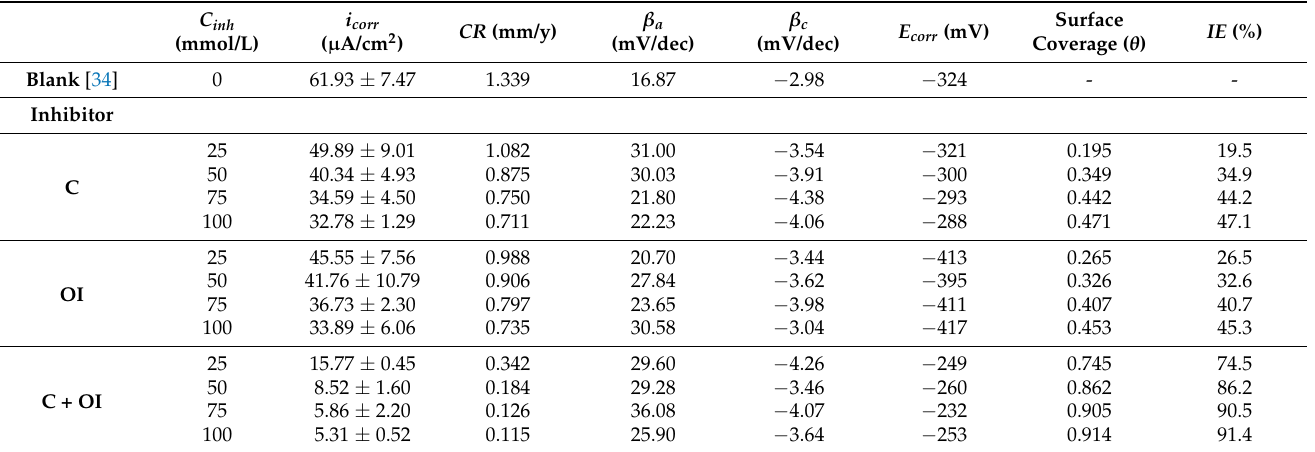
Table 3. PP results for C, OI and C + OI in 0.1 M NaCl. CR is given in millimeter per year (mm/y) depending on current density i corr .